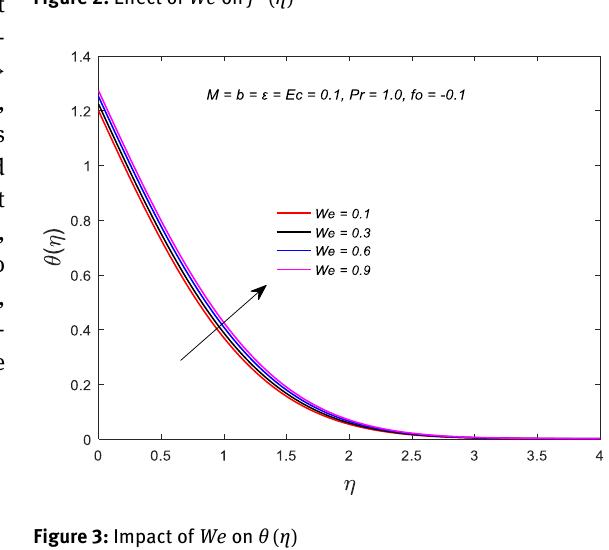
Figure 2: Effect of We on f (cid:48) ( η )